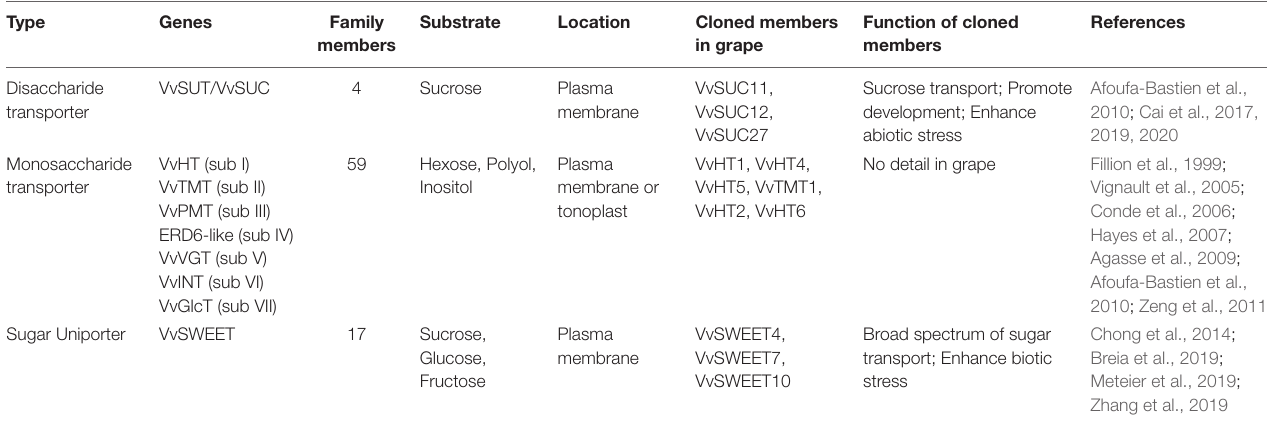
TABLE 1 | The summary information of sugar transporters identified in